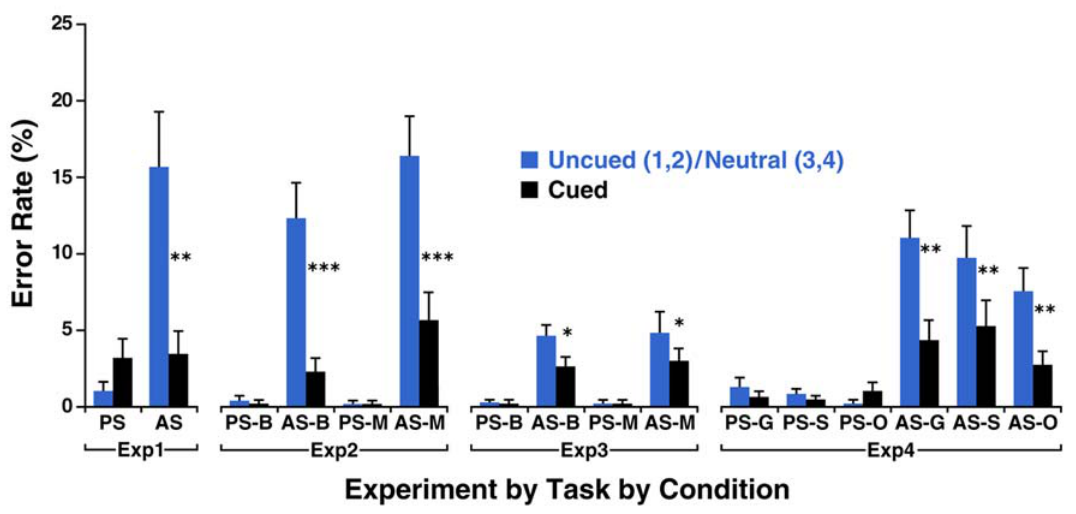
FIGURE 4. Error rates, Experiment 1 and all others. Error rates for cued versus no cue or neutral cue trials for all tasks in each experiment for the shortest delay only. Errors were most likely to occur in the antisaccade task on trials with no directional cue. Exp1, Experiment 1; Exp2, Experiment 2; Exp3, Experiment 3; Exp4, Experiment 4; PS, prosaccade task; AS, antisaccade task; B, blocked presentation; M, mixed presentation; G, gap condition; S, step condition; O, overlap